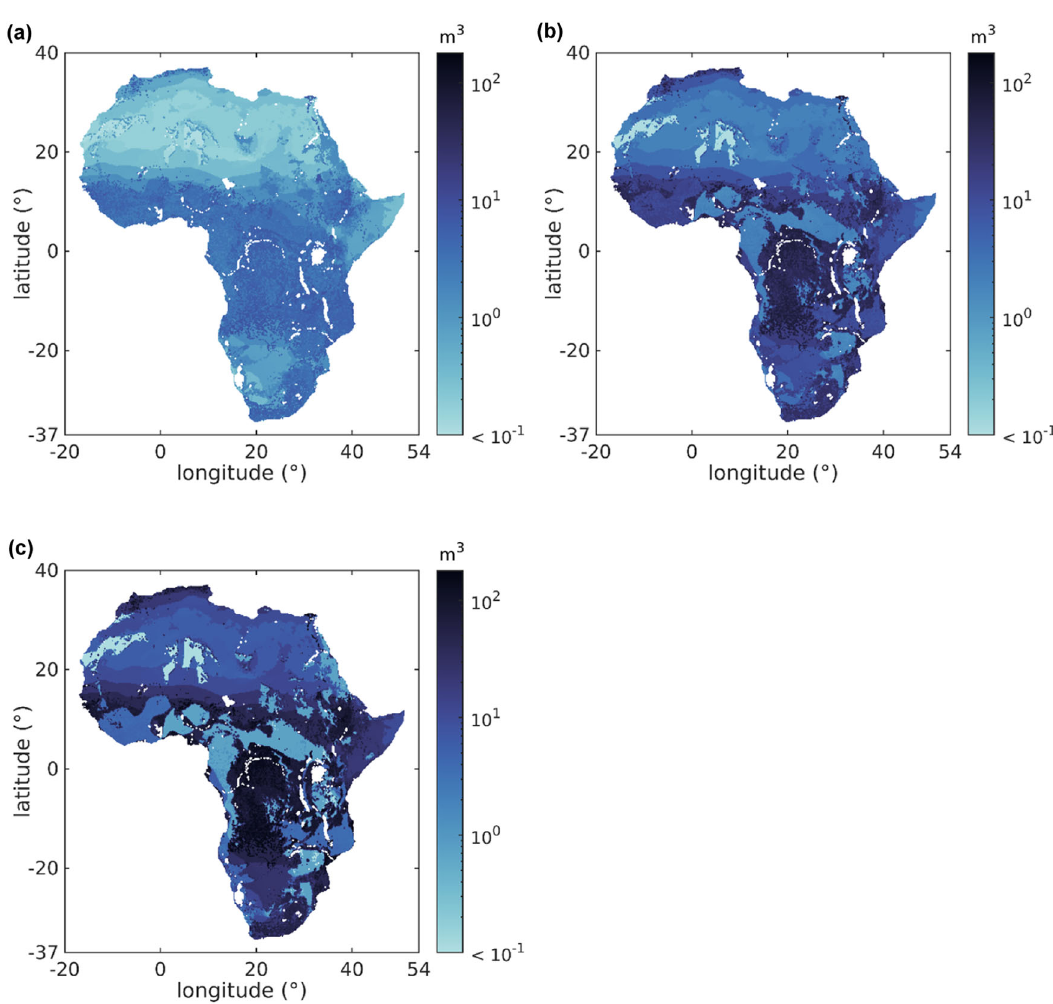
Fig. 5 Average daily pumped volume V for three PVWPS sizes. a P p = 100 W p , b P p = 1000 W p , c P p = 3000 W p for 2020. The results are plotted in a blue scale.